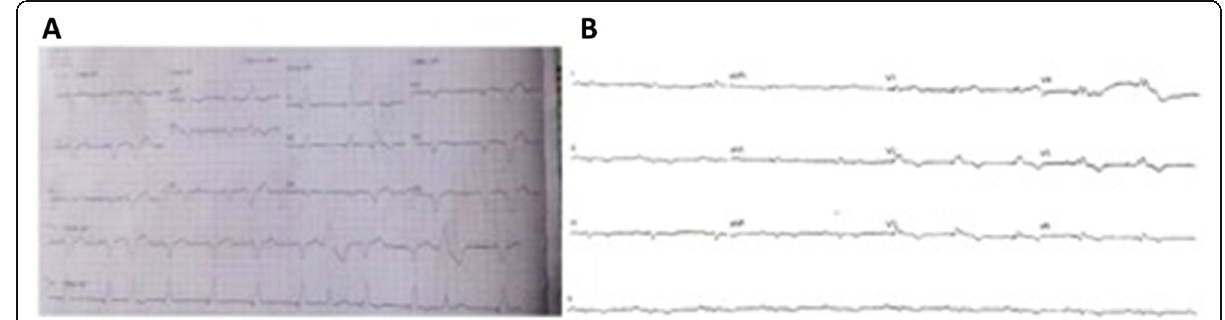
Fig. 2 a Post-CRT paced ECG showed positive V1 and negative lead I with QRS duration of 160 ms. b Post-HBP with LV delay of 40 ms and AV delay of 80 ms, narrow (106 ms) complex QRS was